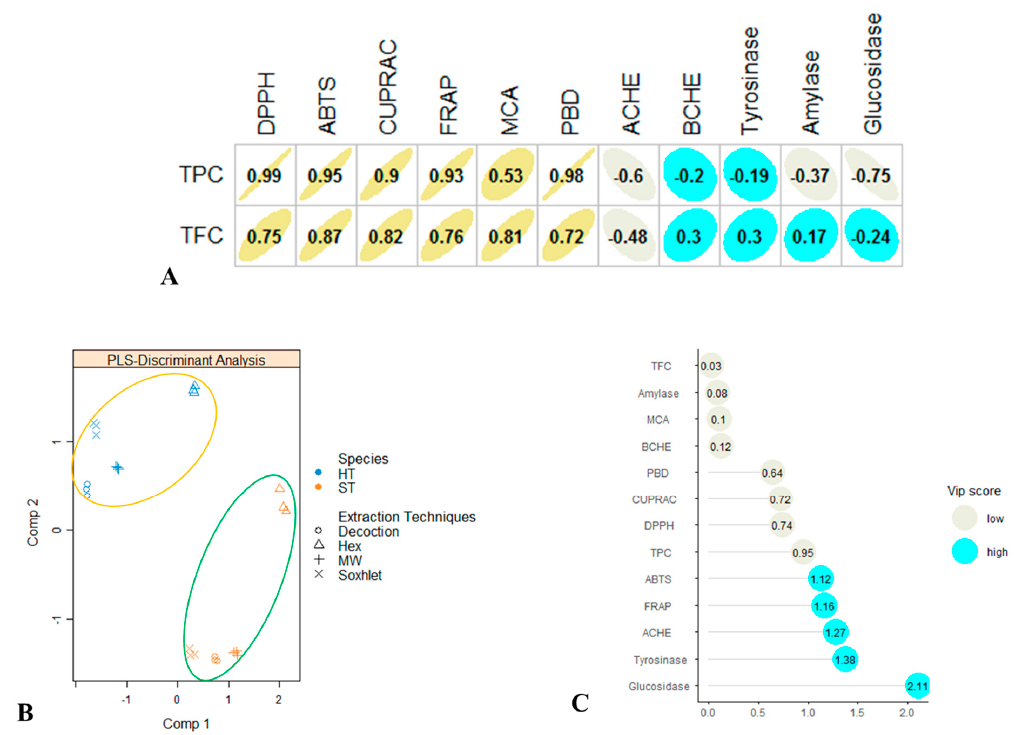
Figure 2. Multivariate analysis. A : Relationship among total phenolic compound (TPC), total flavonoid compound (TFC) and biological activities (Pearson correlation coefficient). B : A sample plot from supervised partial least squared discriminant analysis on biological activities of pepper extracts (HT: hot pepper; ST: sweet pepper). C : The most discriminant biological activities were identified through variable importance in projection (VIP) score calculation.